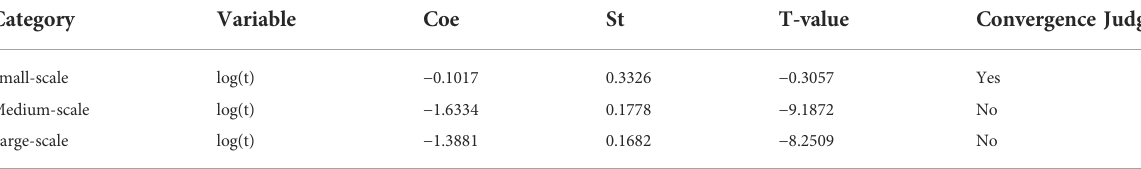
TABLE 4 Overall convergence test (logt test) of environmental ef fi ciency of dairy farming in different scales.